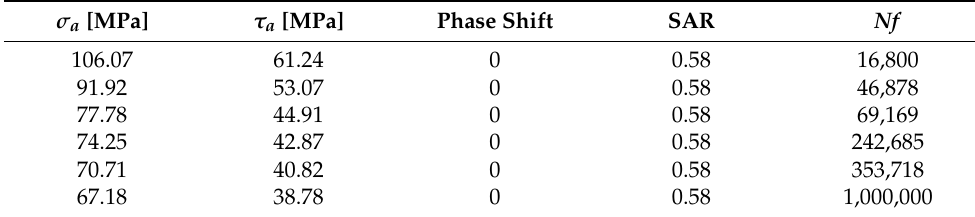
Table 1. Fatigue life results for AZ31BF at proportional reference load ( PP ).